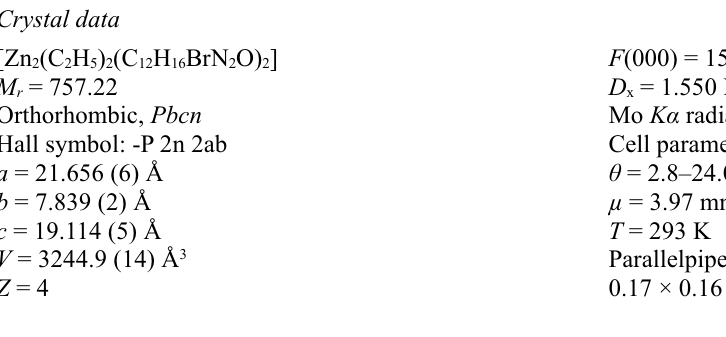
A view of the molecular structure of (I) with displacement ellipsoids shown at the 20% probability level. ( µ -4-Bromo-2-{1-[2-(dimethylamino)ethylimino]ethyl}phenolato)bis[ethylzinc(II)] Crystal